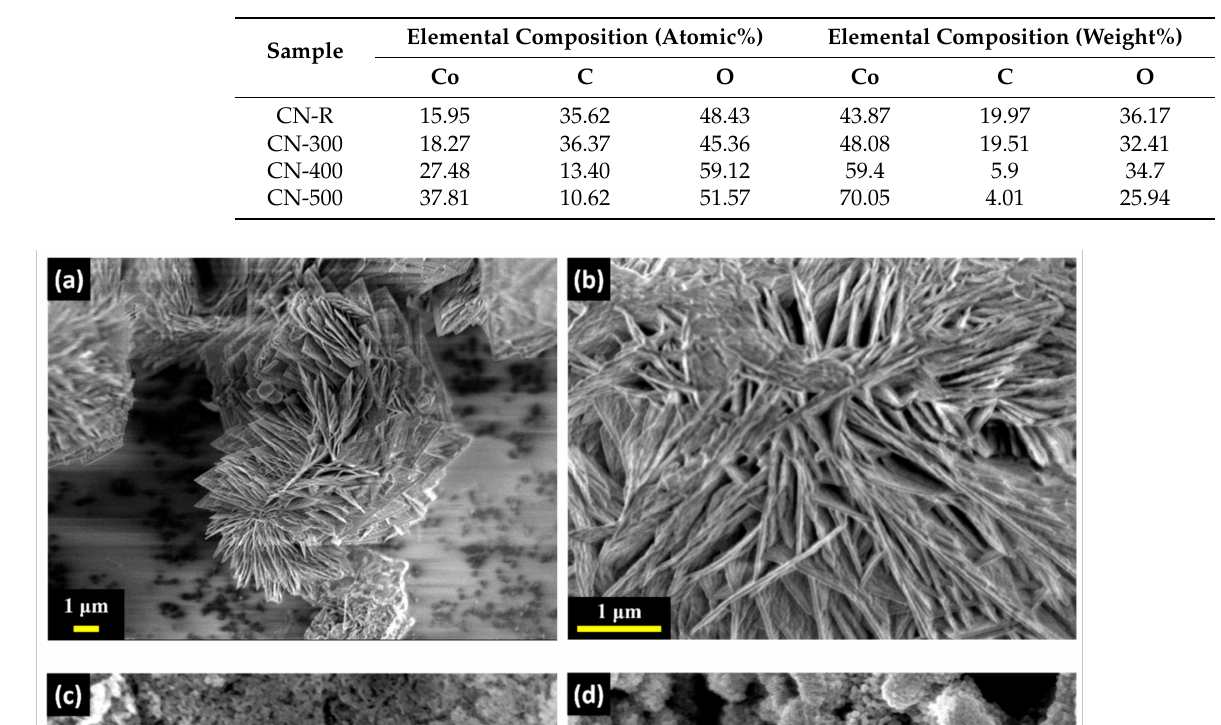
Table 2. Elemental composition of samples.